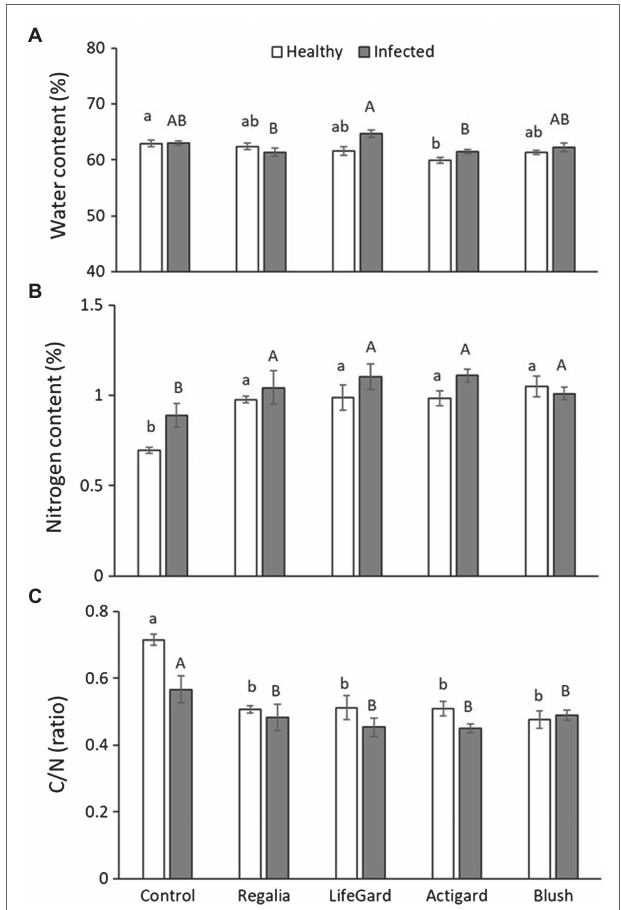
FIGURE 5 | Effects of phytoplasma infection and elicitor treatments on water (A) and nitrogen (B) content and ratio of carbon vs. nitrogen (C/N) (C) in cranberry plants. Data are means ± SE . Different lowercase letters above bars indicate that means among elicitor treatments differ for uninfected (healthy) plants, and different uppercase letters show treatment differences for infected plants (Tukey’s HSD tests, p ≤ 0.05). Control plants did not receive any elicitor (i.e., treated with distilled water only). n = 10 (water content) and three (nitrogen and C/N) replicates per infection/treatment combination.